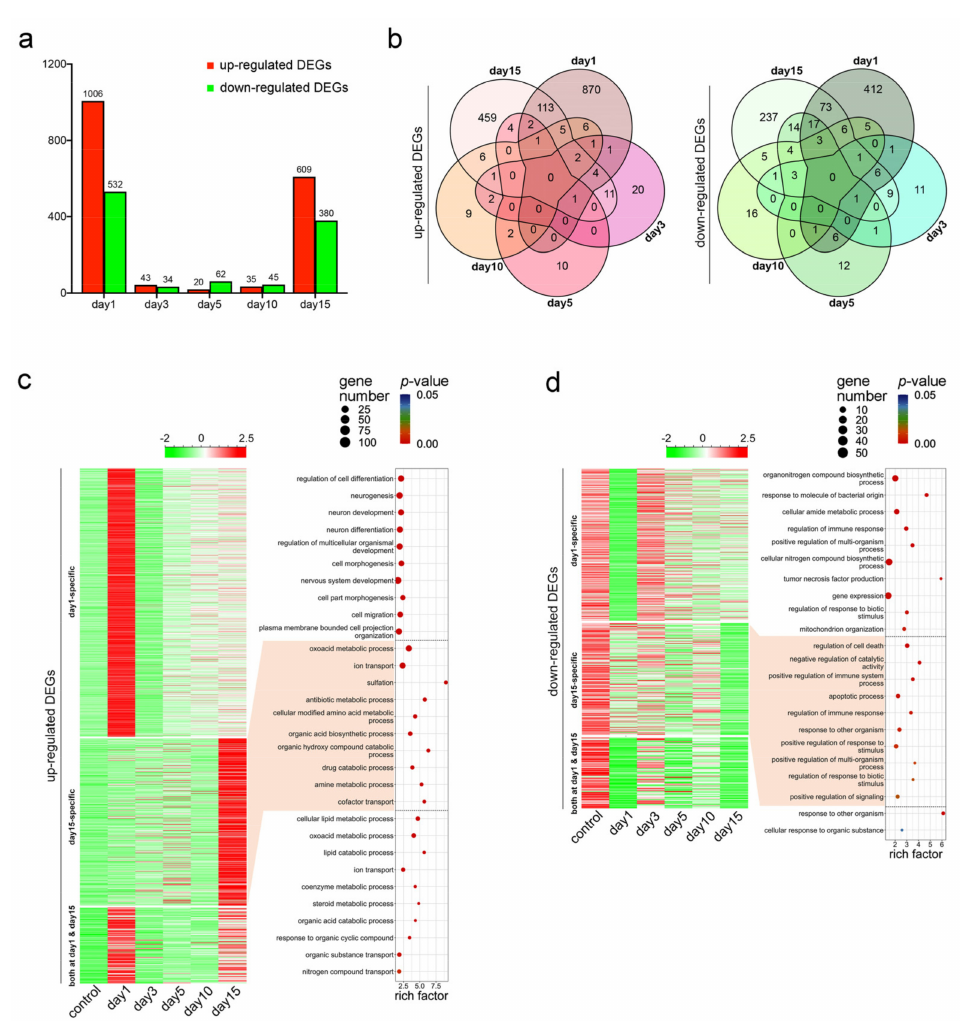
Figure 1. Differentially expressed genes (DEGs) in gills of Chlamys farreri after exposure to toxic Alexandrium minutum . ( a ) Comparison of the numbers of up- and down-regulated DEGs at each time point post-exposure. ( b ) Venn diagram of DEGs at different time points compared to the control group. Most up- and down-regulated DEGs were induced at 1 or 15 day(s) after exposure. ( c , d ) The heatmaps represented the expression patterns of up- and down-regulated DEGs specifically expressed at day 1 (day 1-specific), day 15 (day 15-specific), and co-expressed in both time points (both at day 1 and day 15), and the top 10 Gene Ontology (GO) terms in the biological process category of these